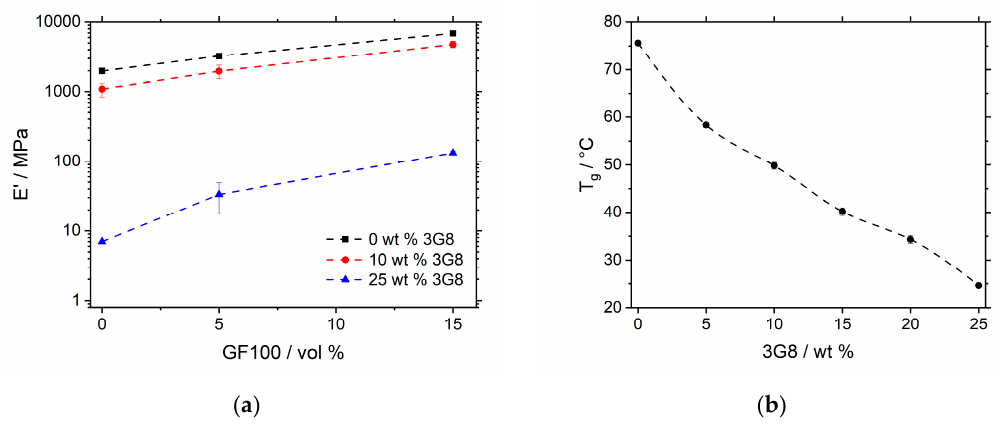
Figure 19. Storage modulus E’ in respect to content of GF100 and softener 3G8 ( a ) and glass transition T g of PVB in respect to softener ( b ). T g of PVB in respect to softener ( b